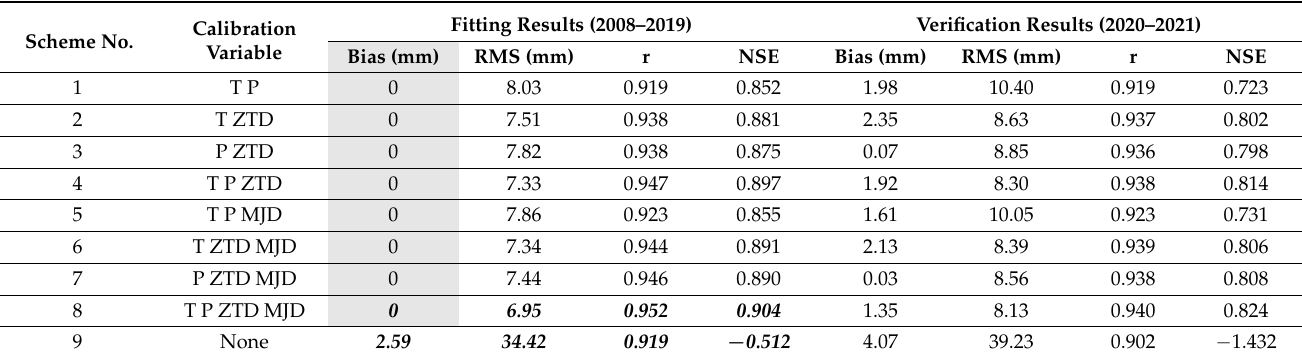
Table 3. Comparison of the average fitting and verification results obtained from each scheme at the three pairs of co-located GNSS/weather